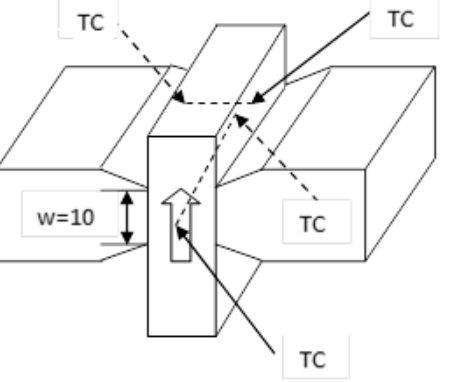
Figure 1. Test device for the deformation by trapezoidal hammers ( ТС are thermocouples).